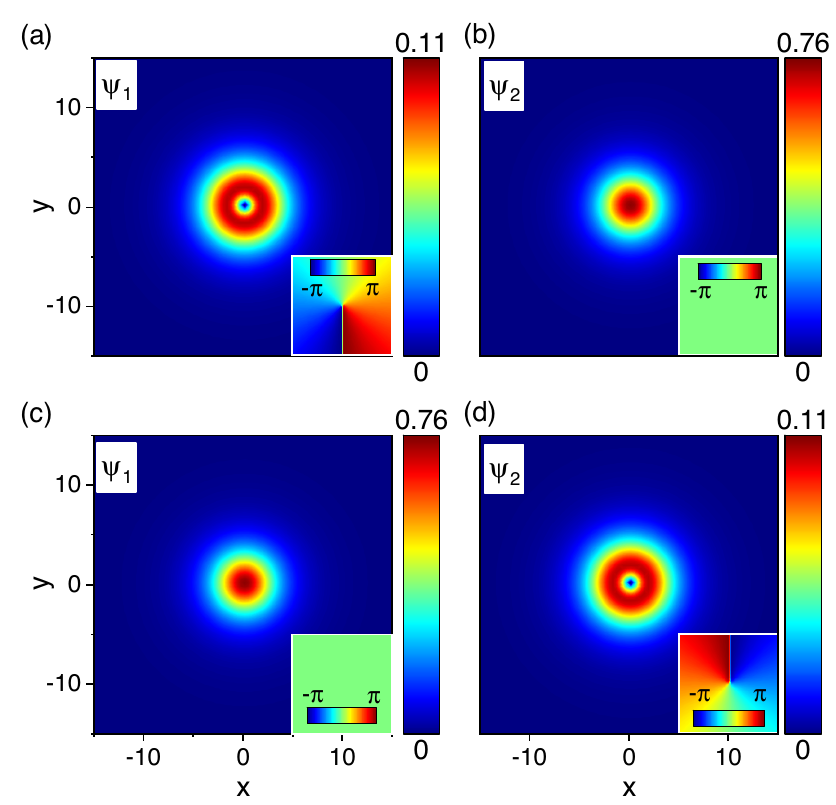
of the bulk soliton at K 1 ; 2